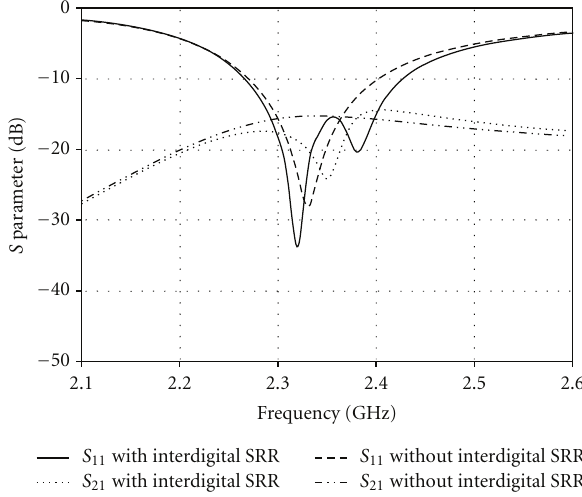
Figure 5: Simulated S parameter characteristic of the proposed MIMO antenna.